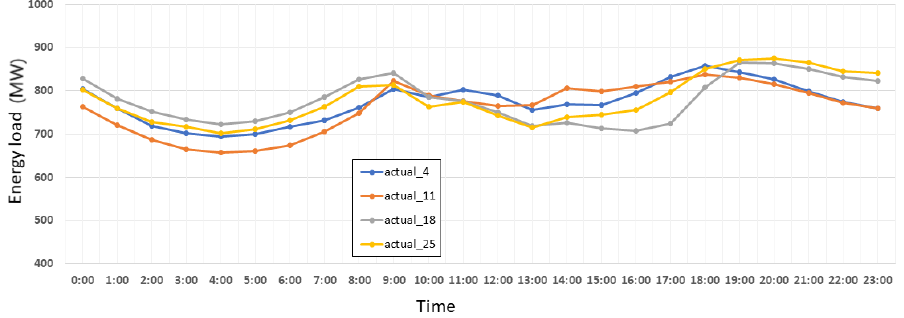
Figure 10. Energy consumption on Fridays in January